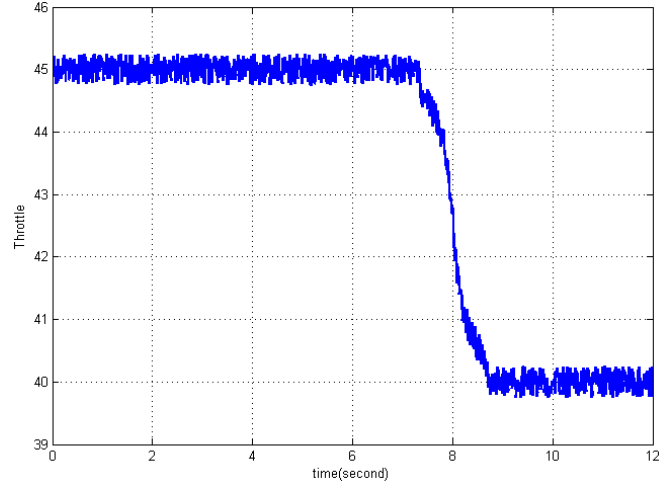
Figure 10. Throttle change during simulation.